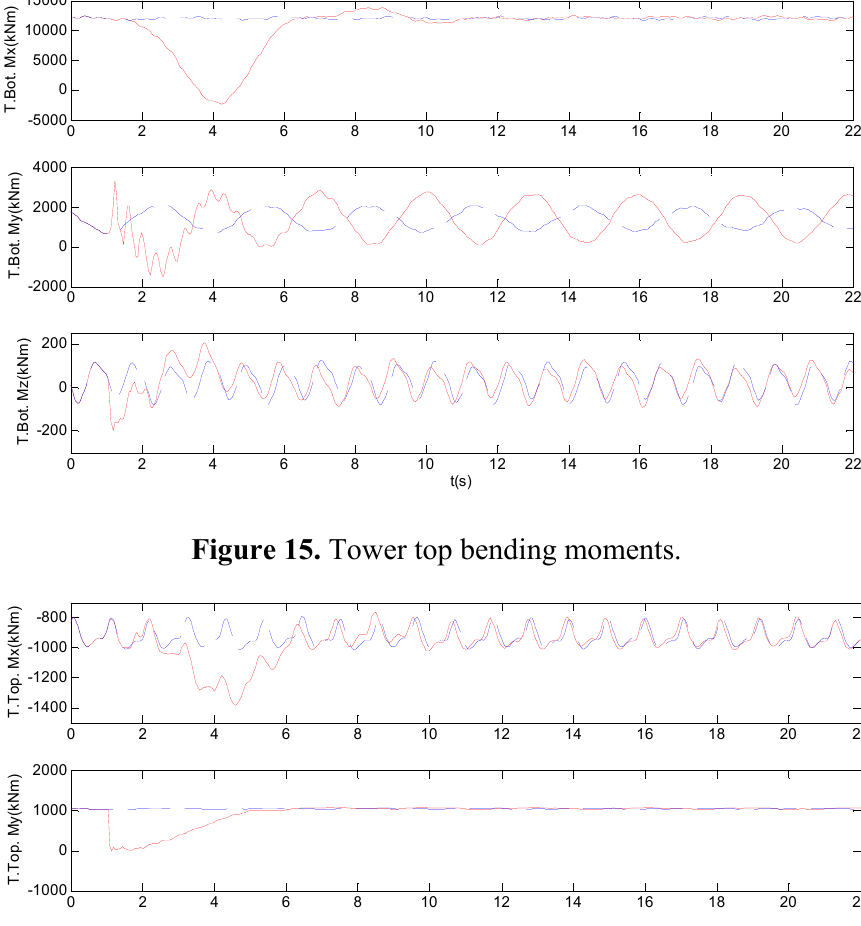
Figure 14. Tower bottom bending moments.